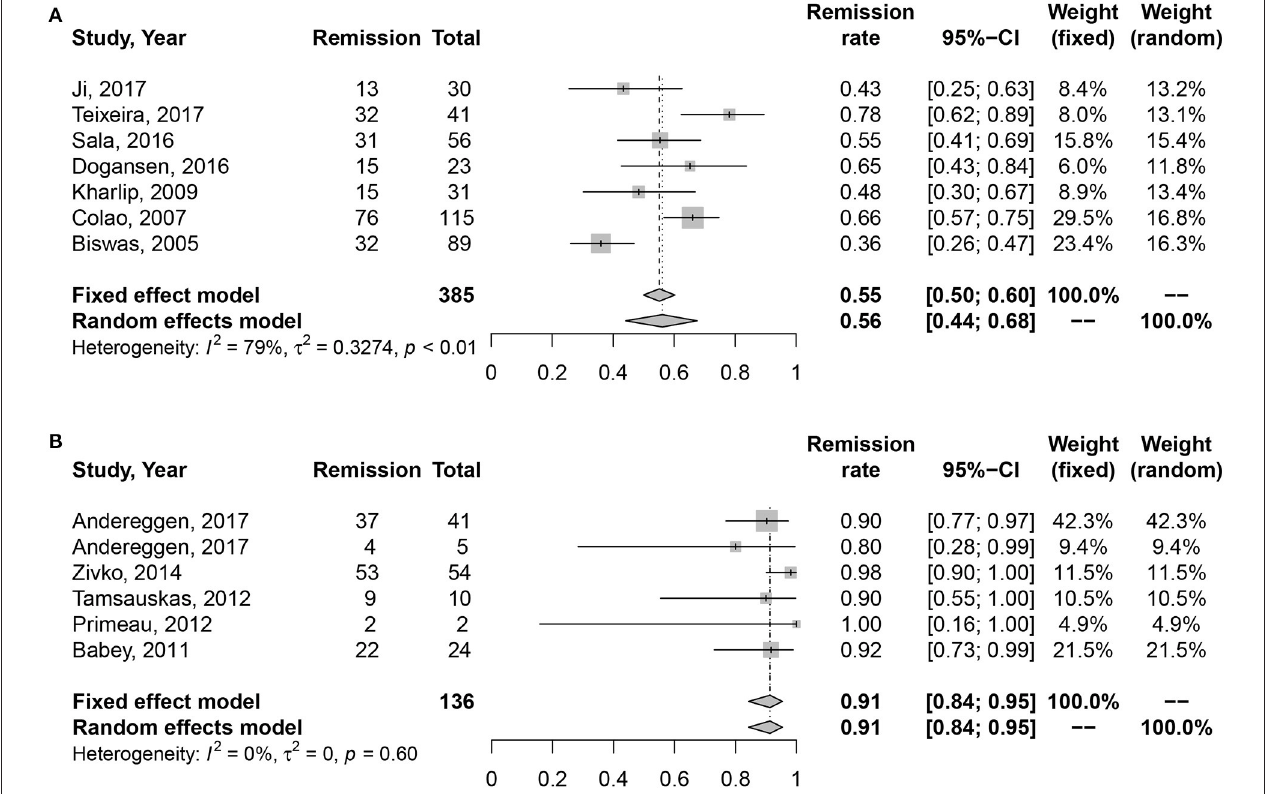
Frontiers in Endocrinology |